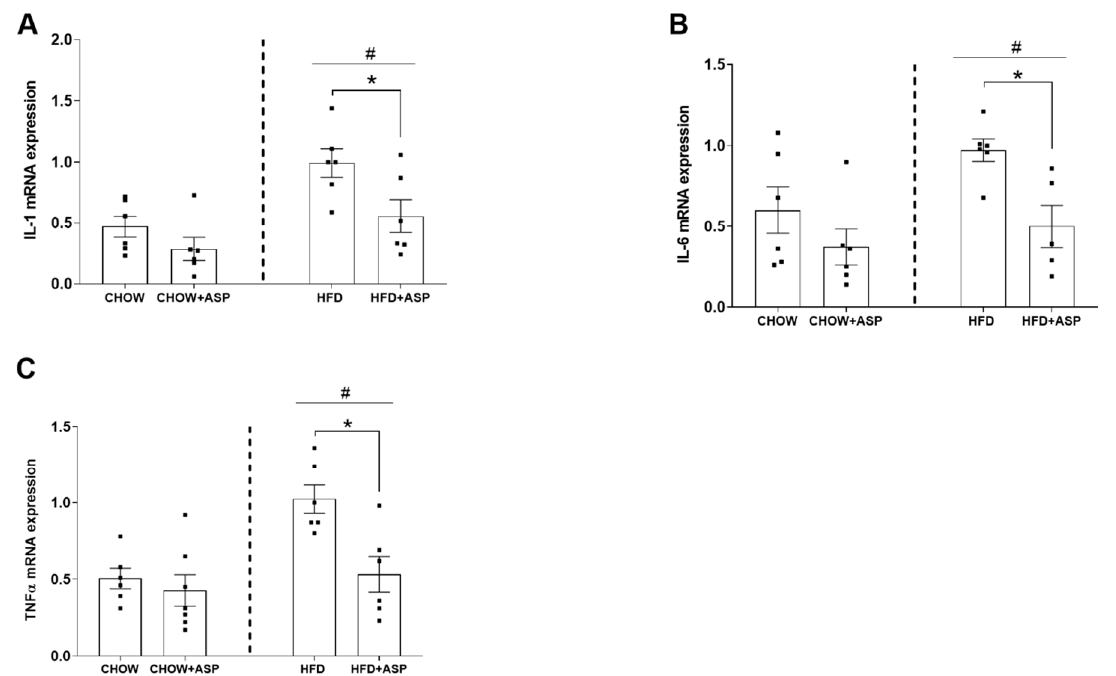
Figure 2. Effect of asperuloside on hepatic genes involved in inflammation: ( A ) Interleukin 1 beta (IL-1 β ); ( B ) Interleukin 6 (IL-6); ( C ) Tumour necrosis factor-alpha (TNF- α ). Standard chow diet (CHOW), High-fat diet (HFD), Asperuloside (ASP). n = 5–6. Standard chow diet (CHOW), high-fat diet (HFD), asperuloside (ASP). Results are expressed as mean ± SEM. Data were analysed by Two-way ANOVA followed by a least significant difference. * Significant ASP effect ( p < 0.05); # Significant overall diet effect [HFD and HFD + ASP] vs. [CHOW and CHOW + ASP] ( p < 0.05).